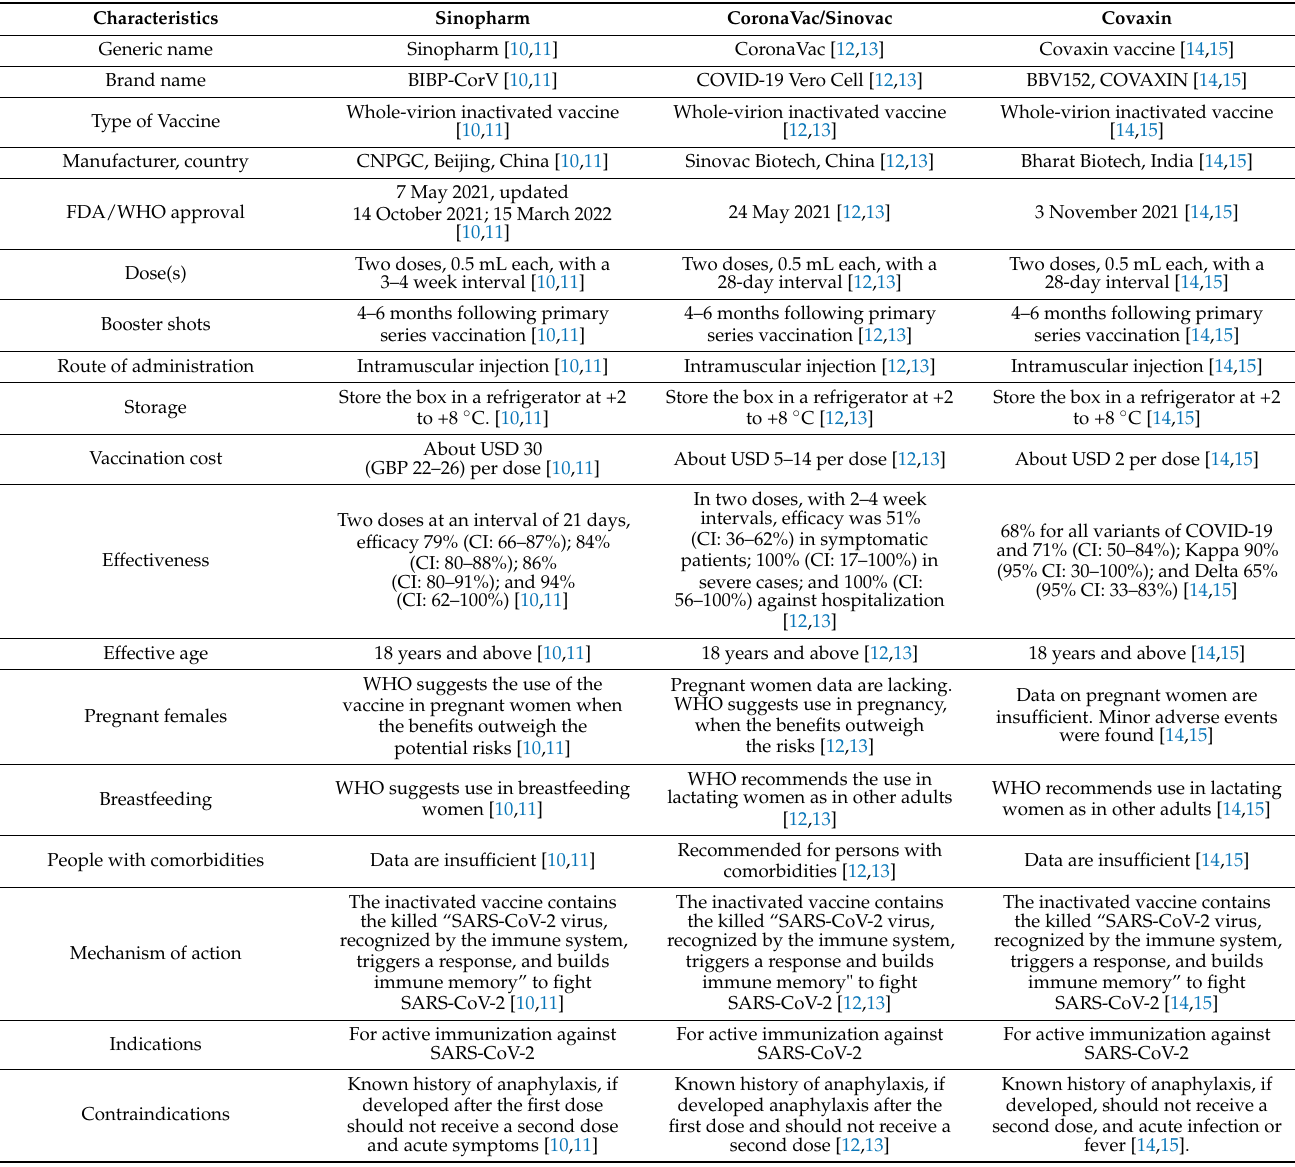
Table 1. Comparison of biological and pharmacological characteristics, indications, contraindications, and mechanisms of action of the COVID-19 vaccines Sinopharm, CoronaVac, and